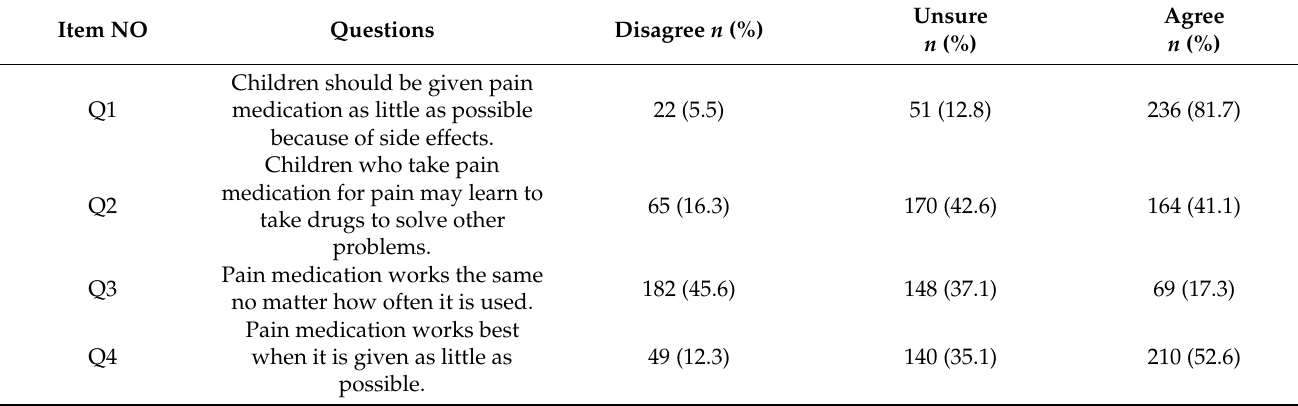
Table 5. Mothers’ attitudes towards children’s pain